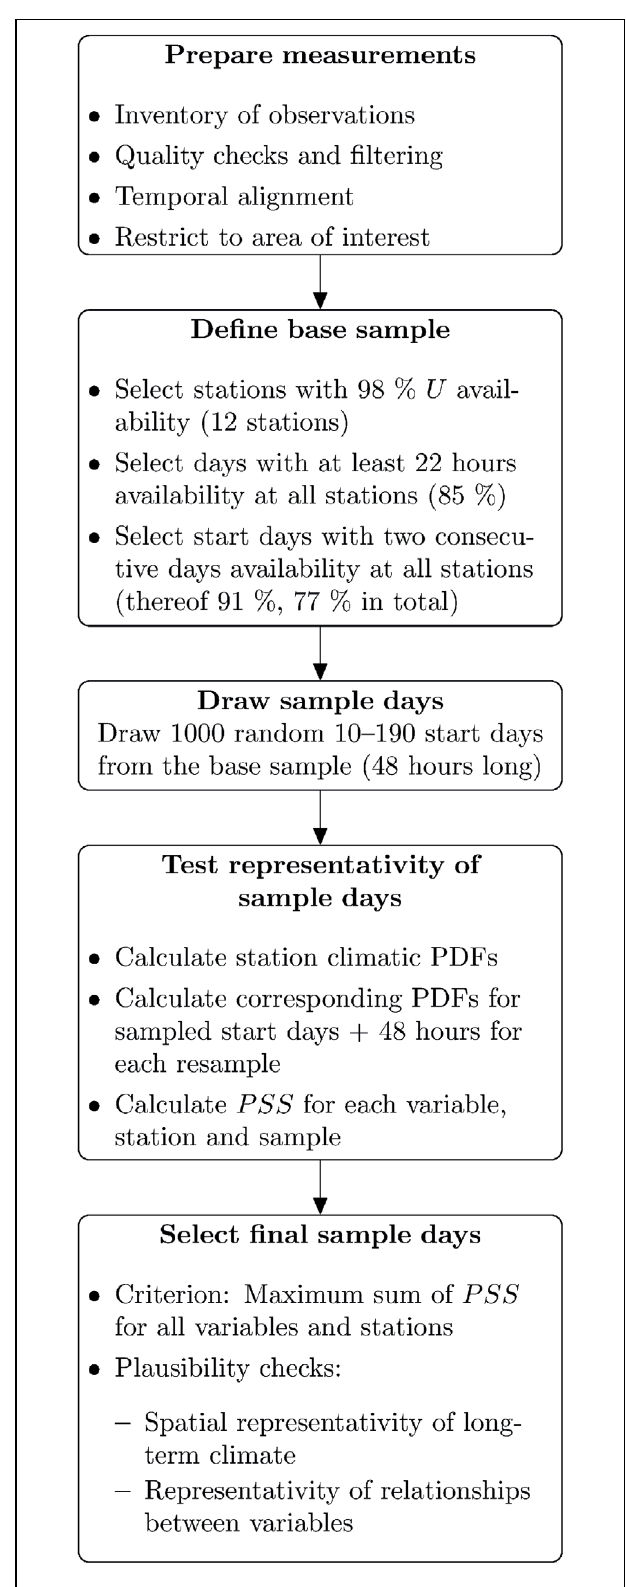
FIGURE 1 | Process for selecting statistically representative days of the 30-years wind and wave climate in the German Bight.